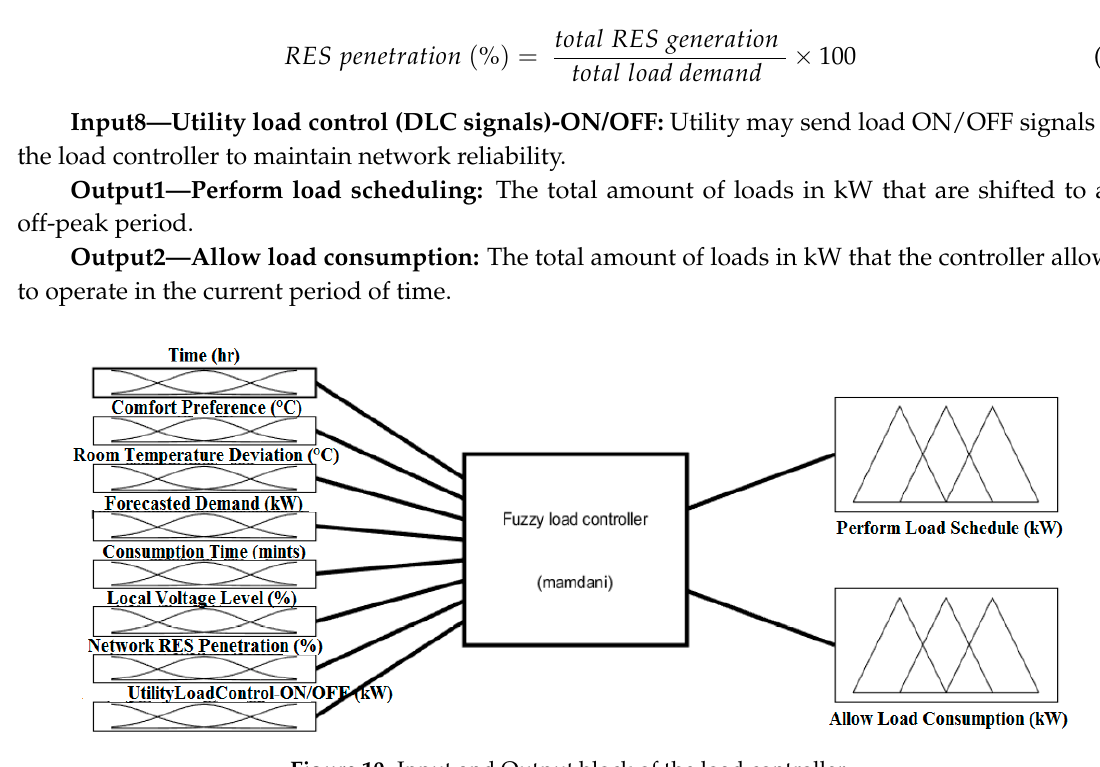
Figure 10. Input and Output block of the load controller.